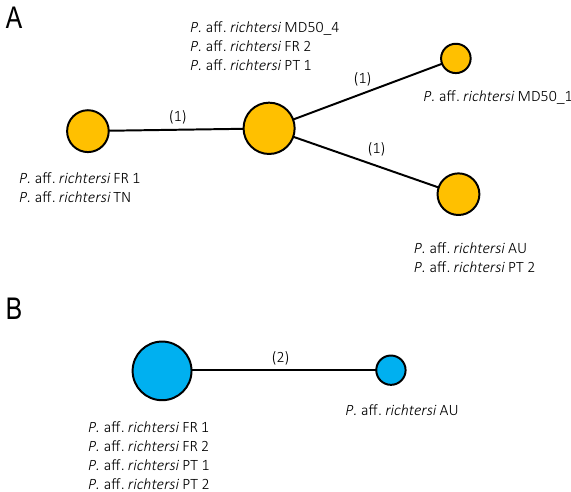
Figure 2. Haplotype Median Joining networks for mitochondrial (COI) and nuclear (ITS-2) markers of P. gadabouti sp. nov: ( A )—COI; ( B )—ITS-2. Haplotypes are represented by coloured circles. The size of circles is proportional to the number sequences/specimens of each particular haplotype. Sequence/specimen names correspond with names presented in phylogenetic tree in Fig. 1. Numbers in brackets indicate the numbers of mutations between the haplotypes.